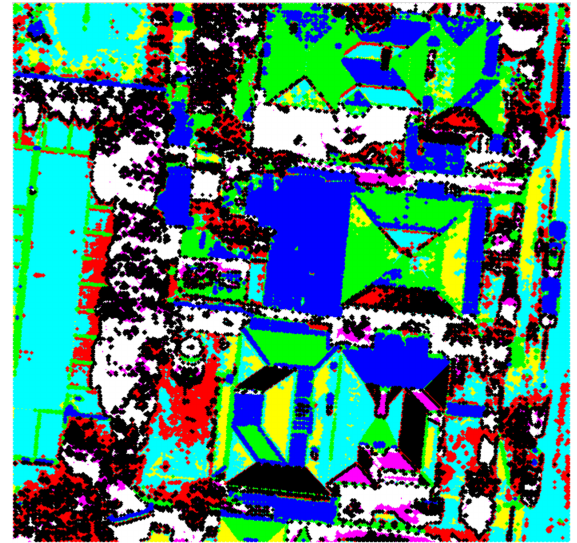
Figure 8: Colour segmentation of the image in Figure